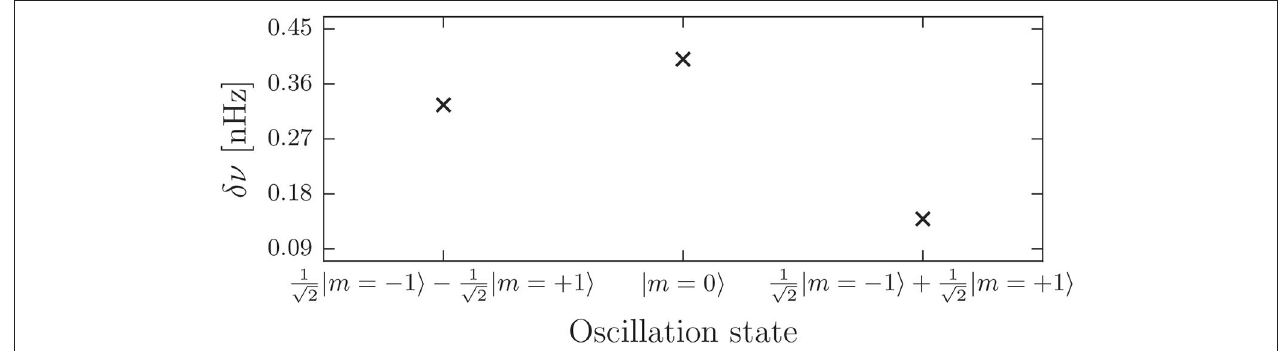
675.6 µ Hz for a flow configuration with s =